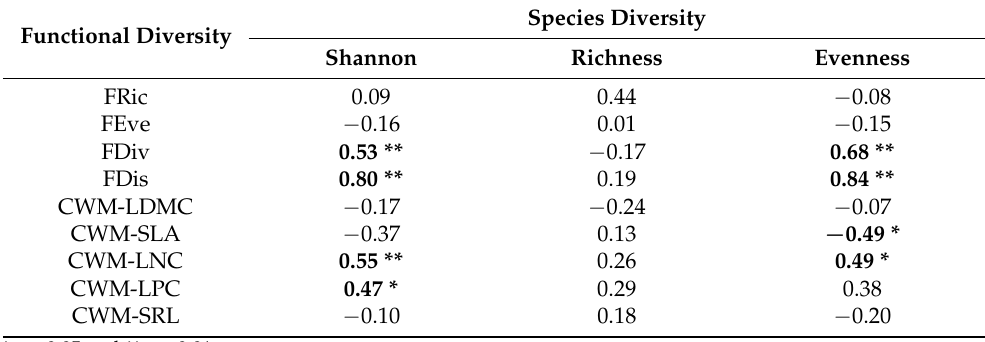
Table 4. Relationships between species diversity and functional attributes for four restoration communities.